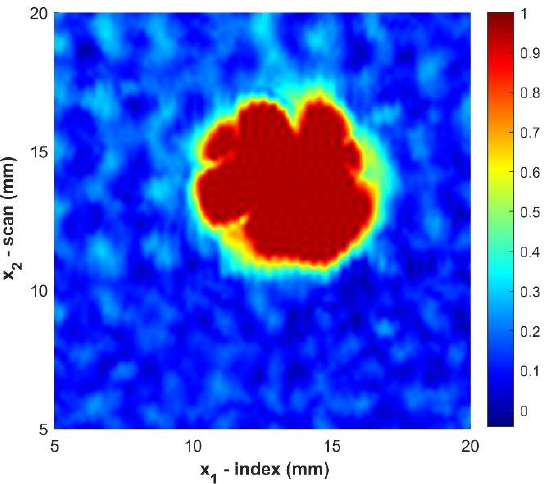
Figure 7. C-Scan of sample B2 using only interpolation. Color indicates the normalized amplitude of the ultrasonic data.